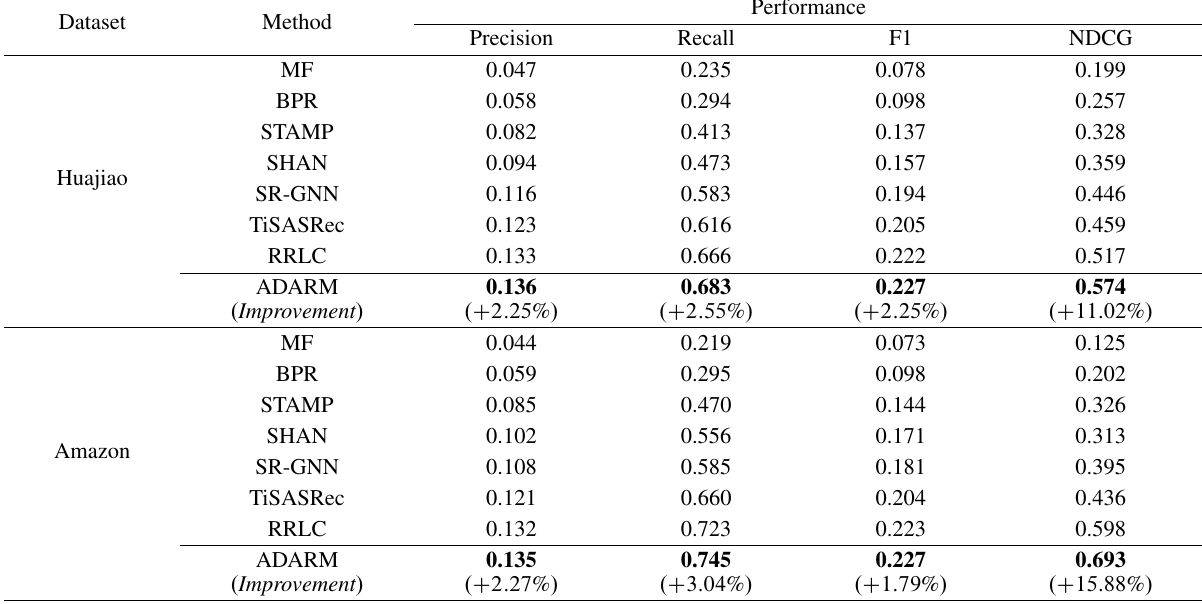
Table 6 Performance comparison among different models for top 10